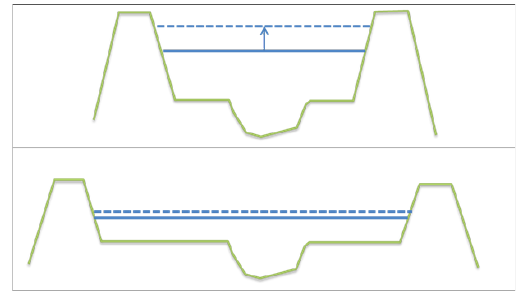
Figure 7. Increase in water level with increasing river discharge in a river with a narrow and one with a wide cross section.